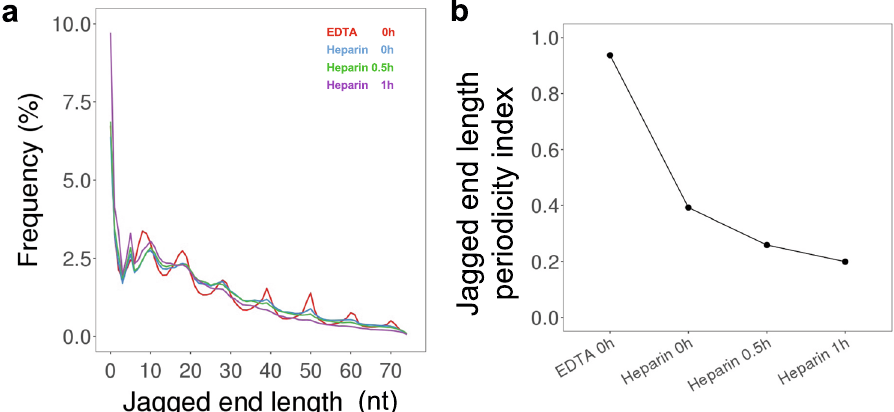
Fig. 5 Effects of heparin treatment on jagged ends of urinary cfDNA. a Jagged end length distribution in urinary cfDNA with heparin incubation treatment. The lines with red, blue, green, and purple colors represent jagged end length distribution at EDTA 0 h, heparin 0 h, heparin 0.5 h, and heparin 1 h treatment, respectively. b Jagged end length periodicity index with EDTA and heparin